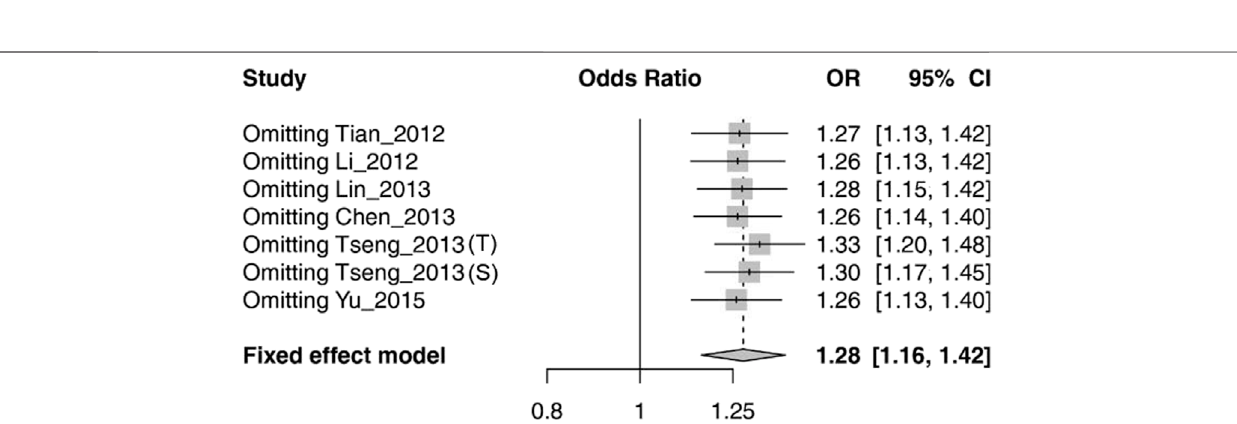
Frontiers in Genetics |